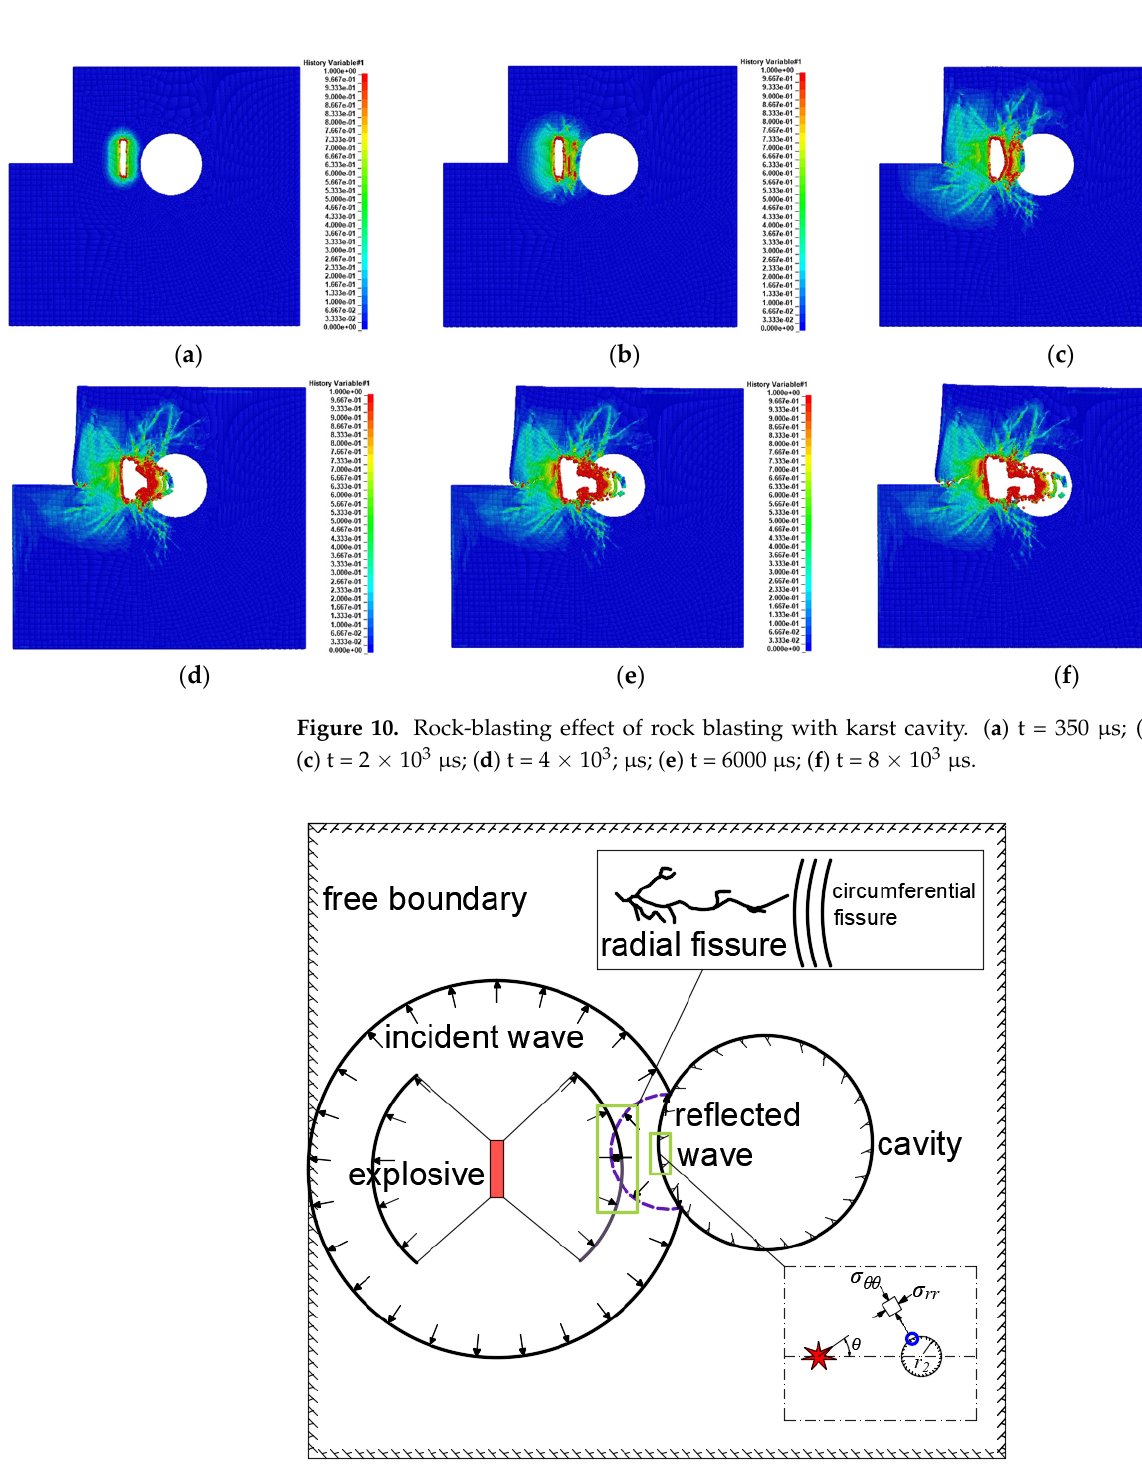
( b ) Figure 9. Comparison of effective stress curves at the interface. ( a ) Stress curve comparison of unit 982415 and unit 892416; ( b ) Stress curve comparison of unit 887172 and unit 887171. 6. Influence of Karst Cavities The damage change of the rock mass with karst affected by the explosive detonation wave is shown in Figure 10. After the explosive explodes, the detonation wave gradually expands the blast hole space, and the detonation wave acts on the blast hole wall to gen- erate stress waves in the rock mass. In the initial stage ( t = 350 μ s), the stress wave with strong energy quickly caused rock damage, and the range was the oblong area around the blast hole. When the stress wave is transmitted to the karst cavity ( t = 750 μ s), the free surface effect of the cavity makes the stress wave reflect to form a tensile wave, and the rock mass on the near-explosion side of the cavity is the first to suffer tensile failure. The stretching wave formed by reflection is transmitted repeatedly between the cavity and the blasthole (t=2000~4000 μ s), the rock mass between the two cavities becomes a stress con- centration tension zone, and the rock mass damage on the side of the cavity is obviously greater than that of the blasthole Symmetrical position, the final result is that the rock mass moves into the cavity after being broken, and the blasting energy accumulates in the cavity;When the stress wave is transmitted along the chassis resistance line to the empty surface of the step ( t = 4000 ‒ 6000 μ s), the damage development on one side of the cavity